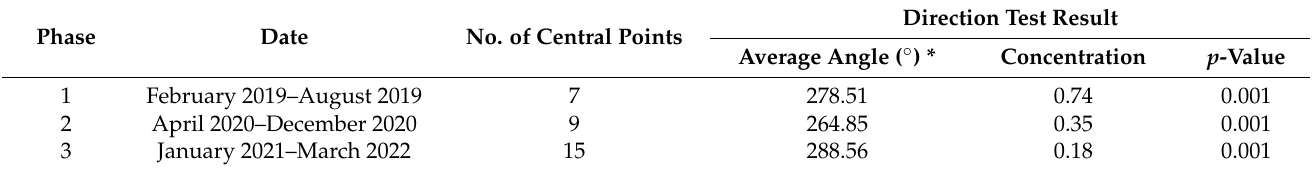
Table 2. The directional test result of the ASF (February 2019–March